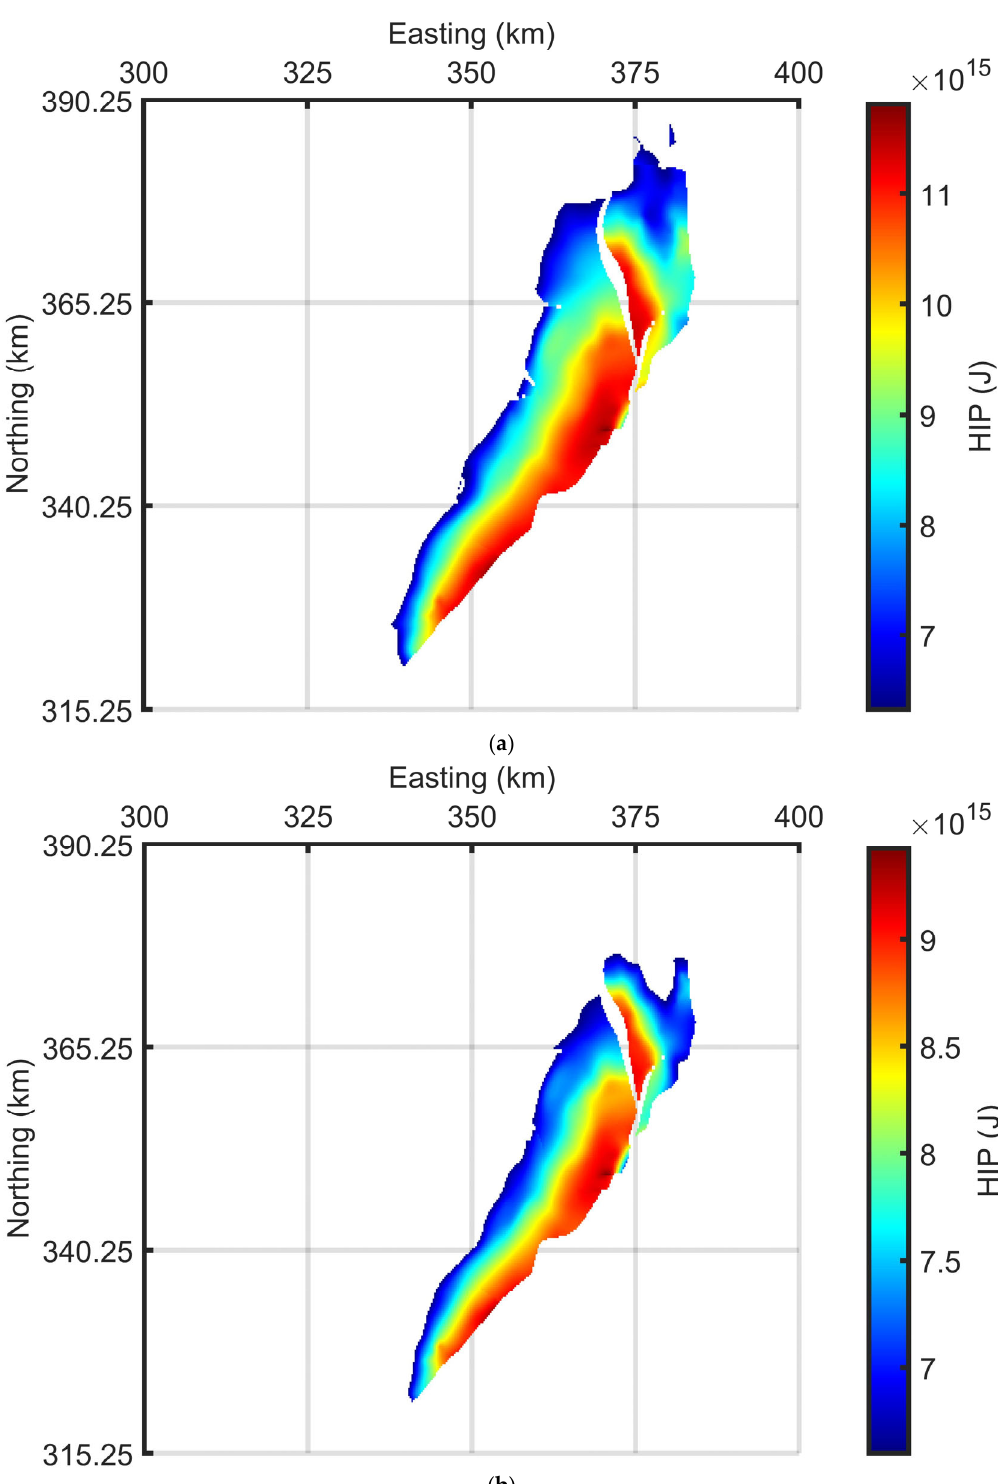
Figure 8. ( a ) Heat in place (HIP) map of the Cheshire Basin using a geothermal gradient of 27 °C/km. Resolution of 250 m spacing. ( b ) Heat in place (HIP) map of the Cheshire Basin using a geothermal gradient of 20 °C/km. Resolution of 250 m spacing. Derived from South West Pennines Model, Lithoframe 3D model—250K data, 13,160 km 2 scale BGS Digital Data under License 2022/067-V2 British Geological Survey © and Database Right UKRI. All rights reserved [58].